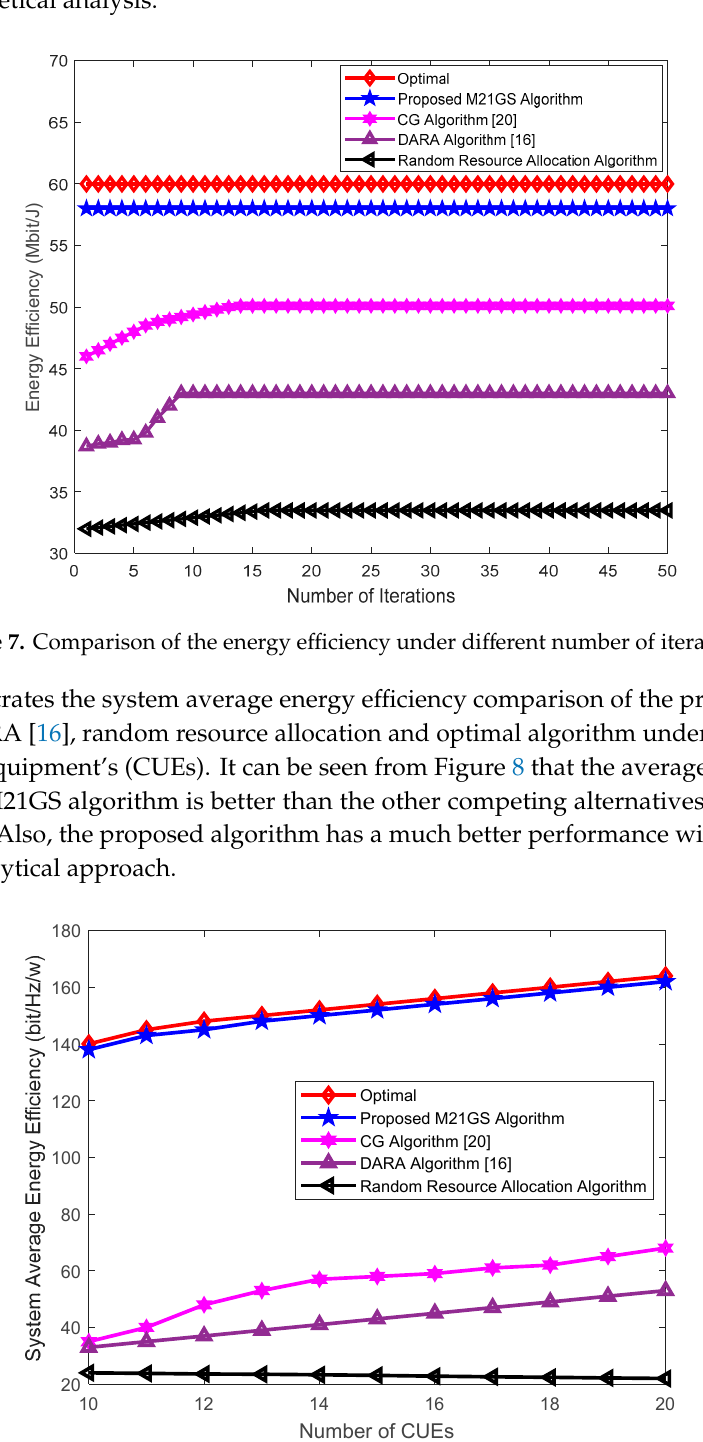
Figure 8. Average Energy Efficiency comparison under different number of CUEs.